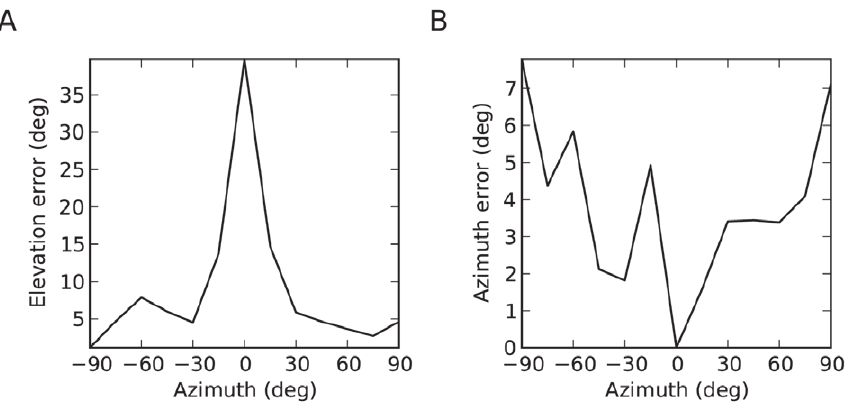
Figure 12. Mean error in estimates of elevation (A) and azimuth (B) of white noise in the approximate model as a function of the azimuth of the sound source. The elevation error at zero azimuth is close to the chance level of 36 degrees.